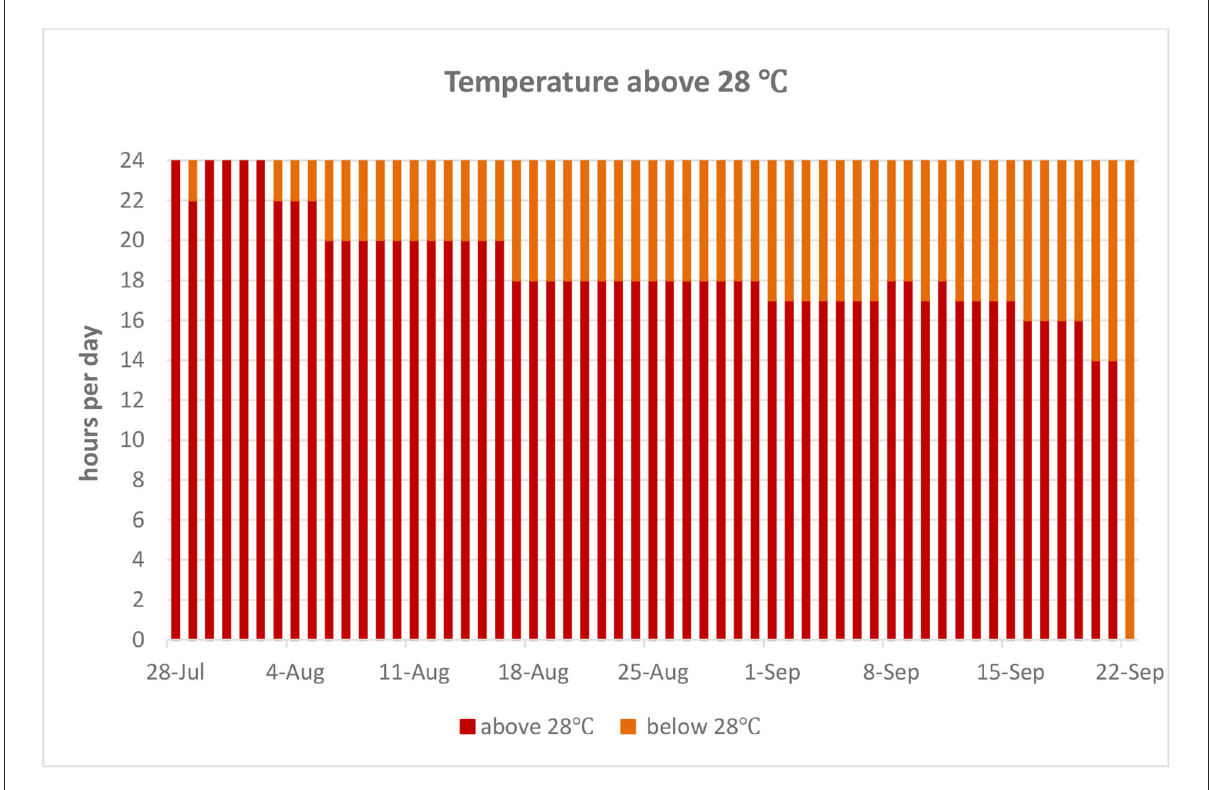
FIGURE2 Total daily hours of in-house temperatures exceeding 28 ◦